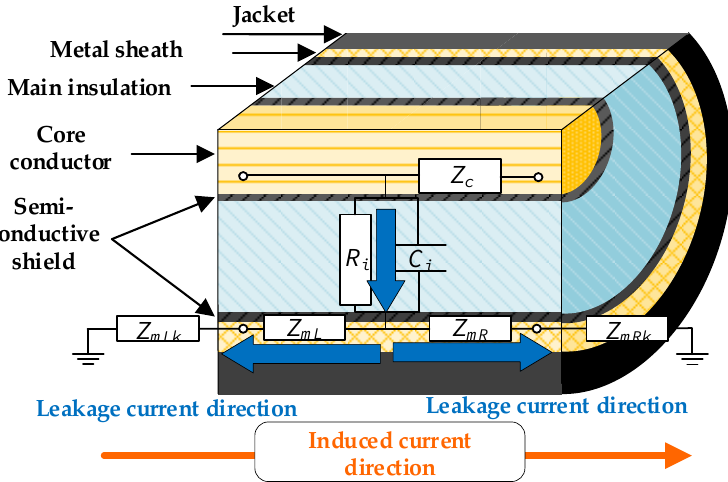
Figure 1. The schematic diagram of the structure and sheath current of HV cable. In the equivalent circuit, Z c represents the equivalent impedance of the core conductor, R i represents the equivalent resistance of the main insulation, C i represents the equivalent capacitor of the main insulation, Z mL represents the equivalent impedance of the left half of the metal sheath, Z mR represents the equivalent impedance of the right half of the metal sheath, Z mLk represents the equivalent ground impedance of the metal sheath on the left side, Z mRk represents the equivalent ground impedance of the metal sheath on the right side.